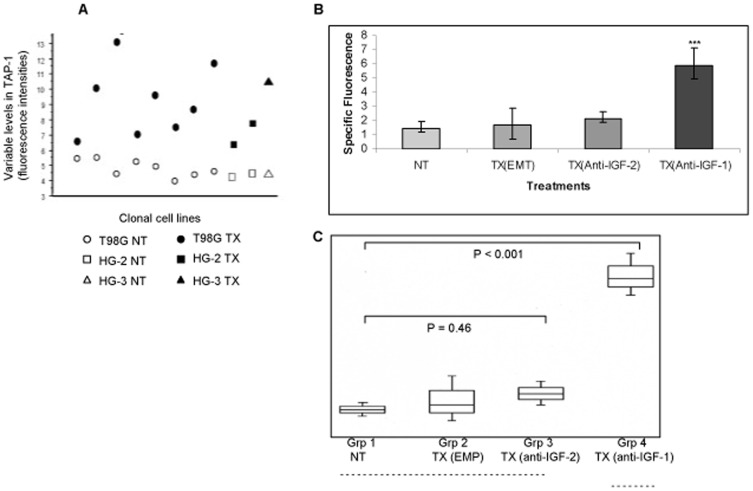
Variability and specificity in expression of TAP-1 in HGB cell lines. A,Variability of TAP-1 levels in pAnti IGF-1 transfected and non-transfected HGB cell lines. Different clones of transfected (TX) and corresponding non-transfected (NT) HGB cell lines, eight from T98G (circles), two from HG-2 (rectangles) and one from HG-3 (triangle), were examined by flow cytometry for the expression of TAP-1. Expression of TAP-1 in TX and NT cell clones were determined using mouse anti-human TAP-1 monoclonal antibody (courtesy of Dr.Robert Tampe) as described in methods. The up-regulated expression of TAP-1 in TX compared to NT clones was significant at the P< 0.05. B, Relative specificity in up-regulation of TAP-1 in pAnti IGF-1 transfected HGB cells. T98G cells were transfected with the vector containing antisense IGF-1 cDNA (TX pAnti IGF-1), with vector containing antisense IGF-2 cDNA (TX pAnti IGF-2), or, with vector containing no antisense sequence (TX pEMT). Transfected cells were comparatively examined by flow cytometry relative to non-transfected T98G cells (NT) for content of TAP-1. The antibody used and flow cytometry analysis were as described in A of this Fig and methods. This experiment was repeated×3. C, TAP-1 expression in comparison of treatments was tested by t-test/ANOVA using Winks SDA software. Boxplot illustrates the comparison in specific fluorescence value among the experimental groups, P<0.001. Represented below the boxplot is the graphical description of Newman-Keuls multiple comparisons.